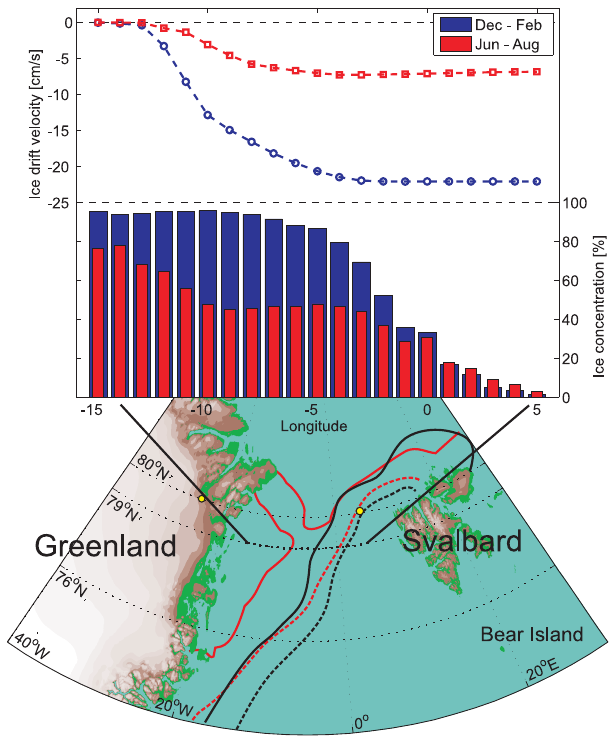
Fig. 1. The Fram Strait between Greenland and Svalbard and mean sea ice properties for 2004–2010. Ice cover for summer (red, June through August) and winter (black, December through February) as solid (50%) and dashed lines (15%) . Above: southward ice drift across 79 ◦ N from August 2004 to July 2010 in 1 ◦ bins based on SAR imagery, and ice concentration from SSMI and AMSR data. The ice area export is found by multiplying the ice drift and ice concentrations. Yellow circles show locations for surface pressure data